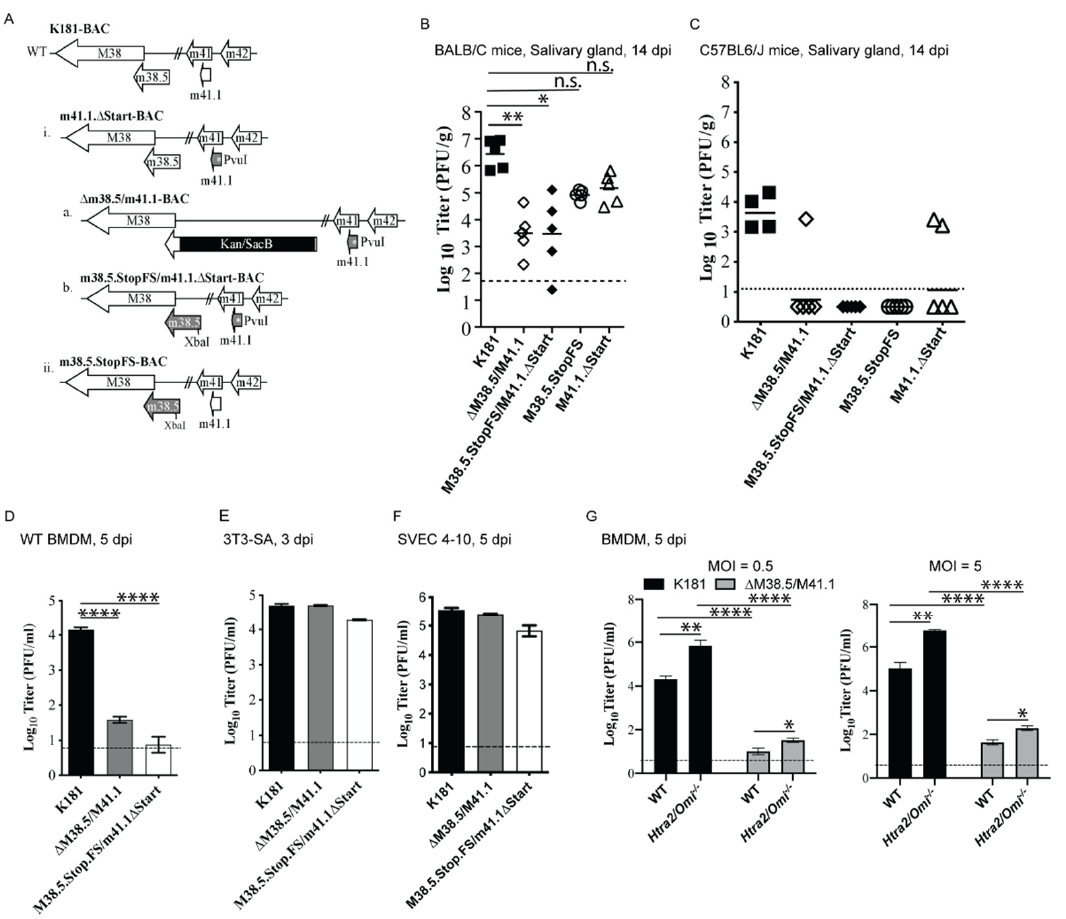
Figure 1. ∆ M38.5/M41.1 mutant MCMV is attenuated for replication in vivo in macrophages. ( A ) Diagrammatic representation of the mutations introduced into M38.5 (vMIA) and M41.1 (vIBO). ( B , C ) Titer of parental MCMV (K181) or indicated mutant viruses in salivary glands from 6-week-old BALB/c ( B ) or C57BL6/J ( C ) mice at 14 dpi following inoculation with 2 × 10 5 PFU intraperitoneally ( B ) or 5 × 10 6 PFU subcutaneously into a footpad ( C ). Each symbol represents the titer obtained from a single mouse. Datasets are compared using one-way ANOVA and the mean for each dataset is indicated. ( D – F ) Replication in C57BL6/J wild type (WT) murine BMDM infected at multiplicity of infection (MOI) of 0.5 ( D ); 3T3-SA fibroblasts ( E ) and SVEC4-10 endothelial cells ( F ) infected at MOI of 0.3. Data shown are pooled results from three experiments for each setting and the dotted line indicates the limit of detection for each group. Each data set is compared using one-way ANOVA. ( G ) Replication of K181 or ∆ M38.5/M41.1 virus in WT and Htra2/Omi − / − BMDM at 5 dpi following infection at an MOI = 0.5 (left panel) or 5 (right panel). For each panel, data shown are pooled results from at least three experiments. Horizontal lines indicate data compared by Wilcoxon matched-pairs signed rank test. For panels ( D – G ), error bars indicate the standard error and mean for each dataset. * is p < 0.05; ** is p < 0.01; **** is p < 0.0001, n.s. is non-significant.